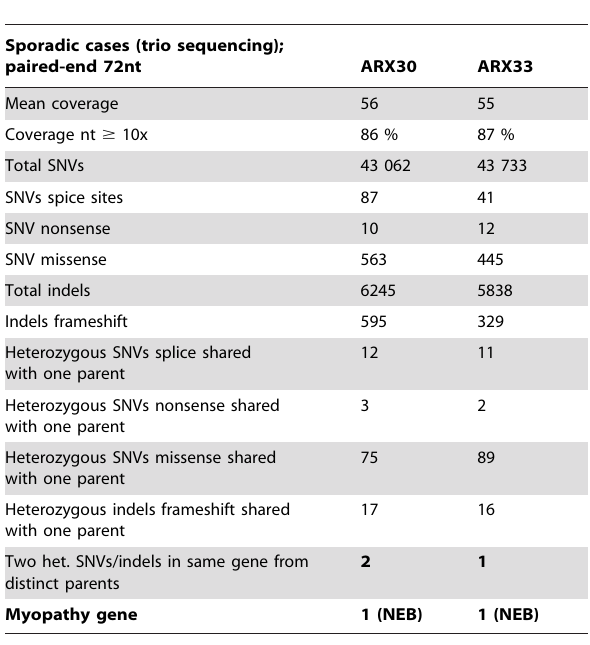
Table 4. Statistical overview of the exome sequencing results: sporadic case